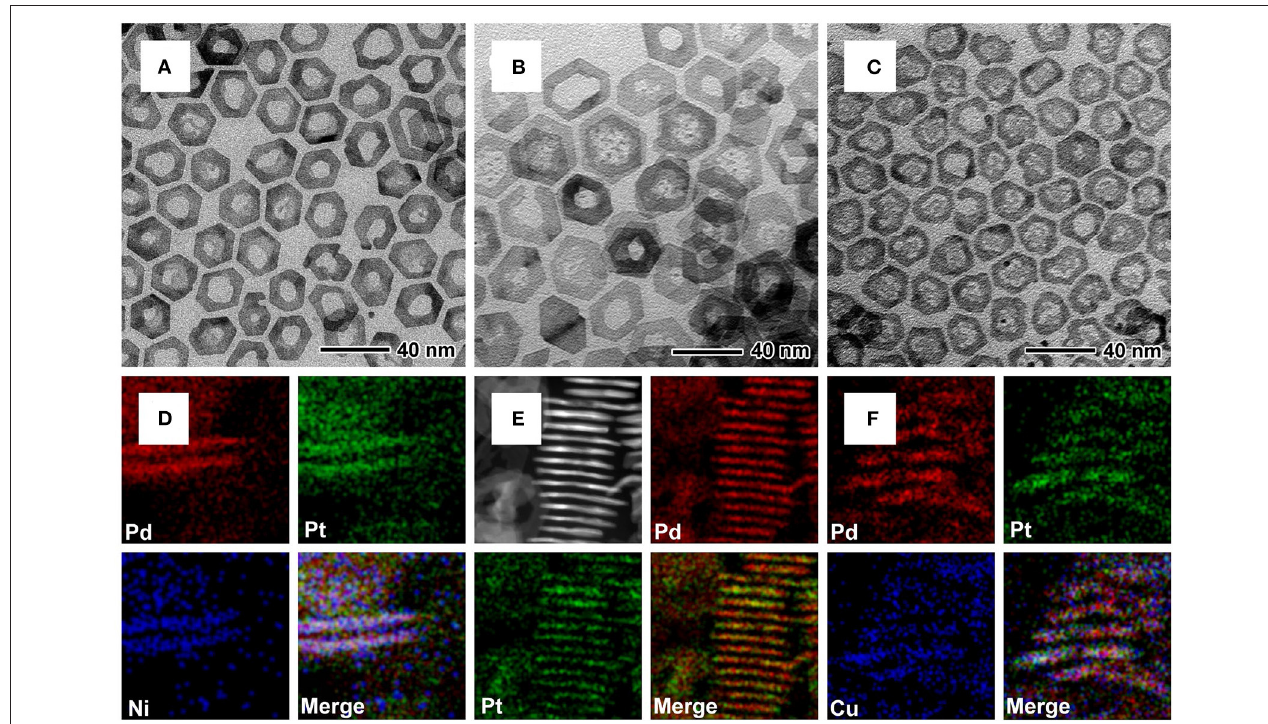
FIGURE 2 | TEM and HAADF-STEM-EDX mapping images for (A,D) Pd@PtNi nanorings, (B,E) Pd@PtPd nanorings, and (C,F) Pd@PtCu nanorings, respectively.